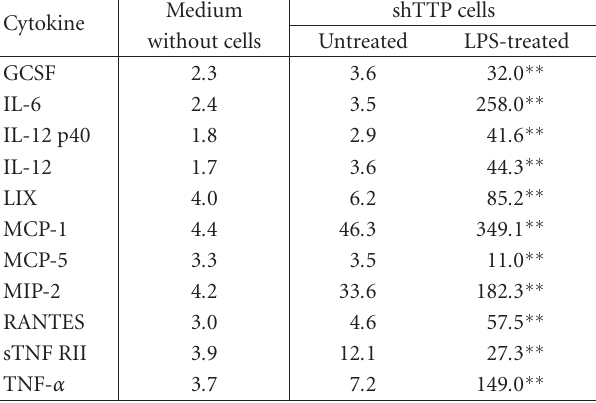
Table 4: Cytokines secreted by untreated and LPS- (100ng/mL) treated shTTP cells during 48h incubation. Arbitrary units com- pared to positive controls (100) are presented. Mean